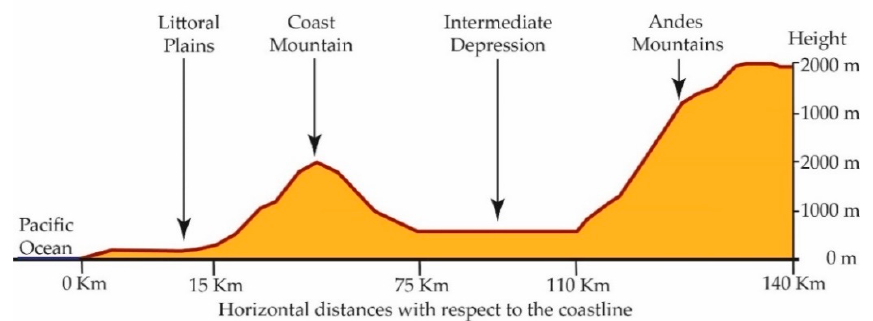
Figure 2. Topographic profile central zone of Chile 33° South Latitude.